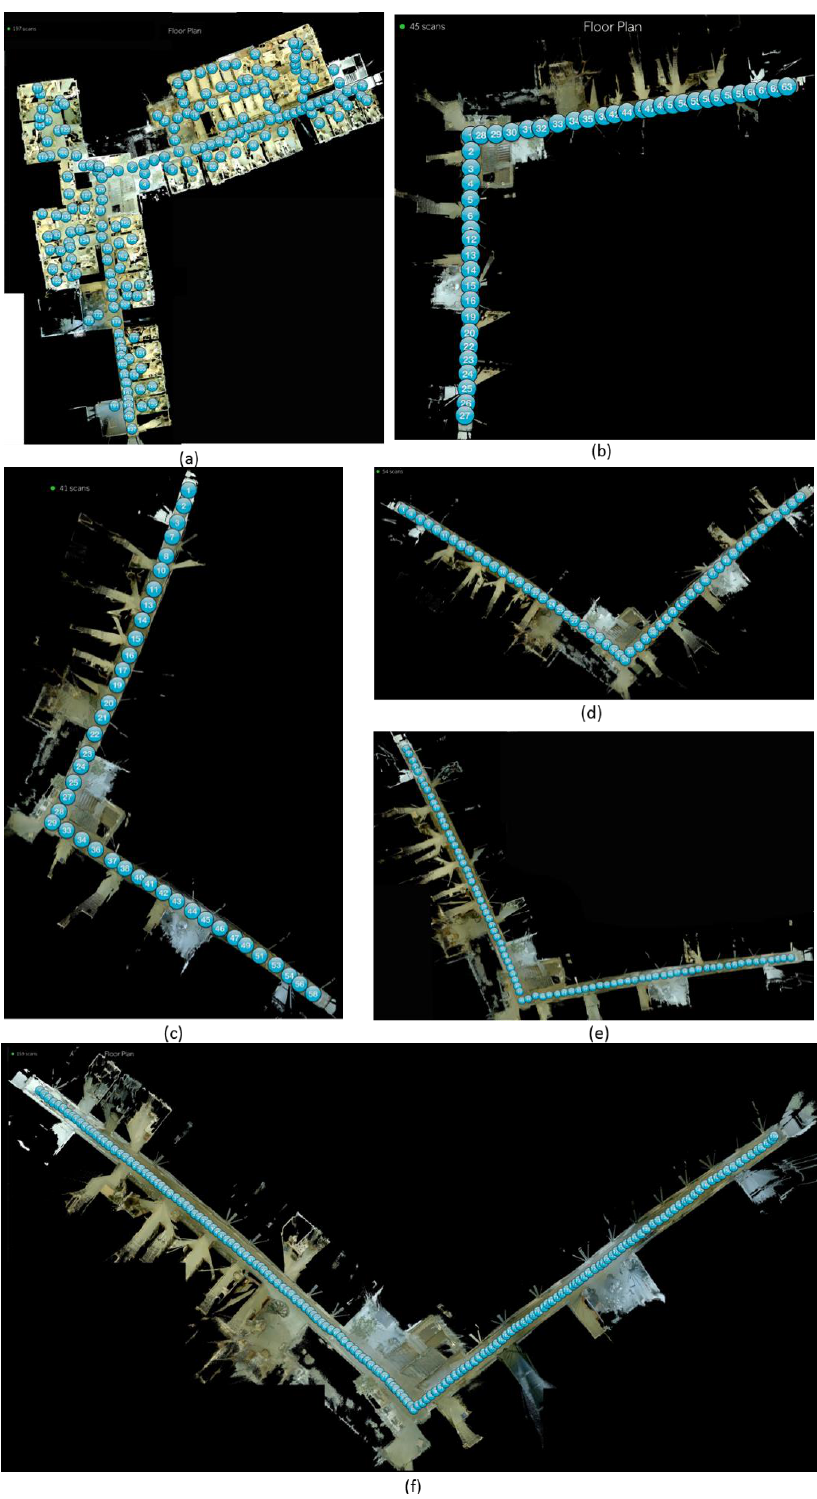
Figure 6. Floor map dataset generated by different setups of Matterport with positions of each scan ( a ) T1: random neighboring scan distance starting from the corner; ( b ) T2: 2 m neighboring scan distance starting from the corner; ( c ) T3: 2 m neighboring scan distance starting from the end; ( d ) T4: 1.5 m neighboring scan distance starting from the end; ( e ) T5: 1 m neighboring scan distance starting from the end; ( f ) T6: 0.5 m neighboring scan distance starting from the end.